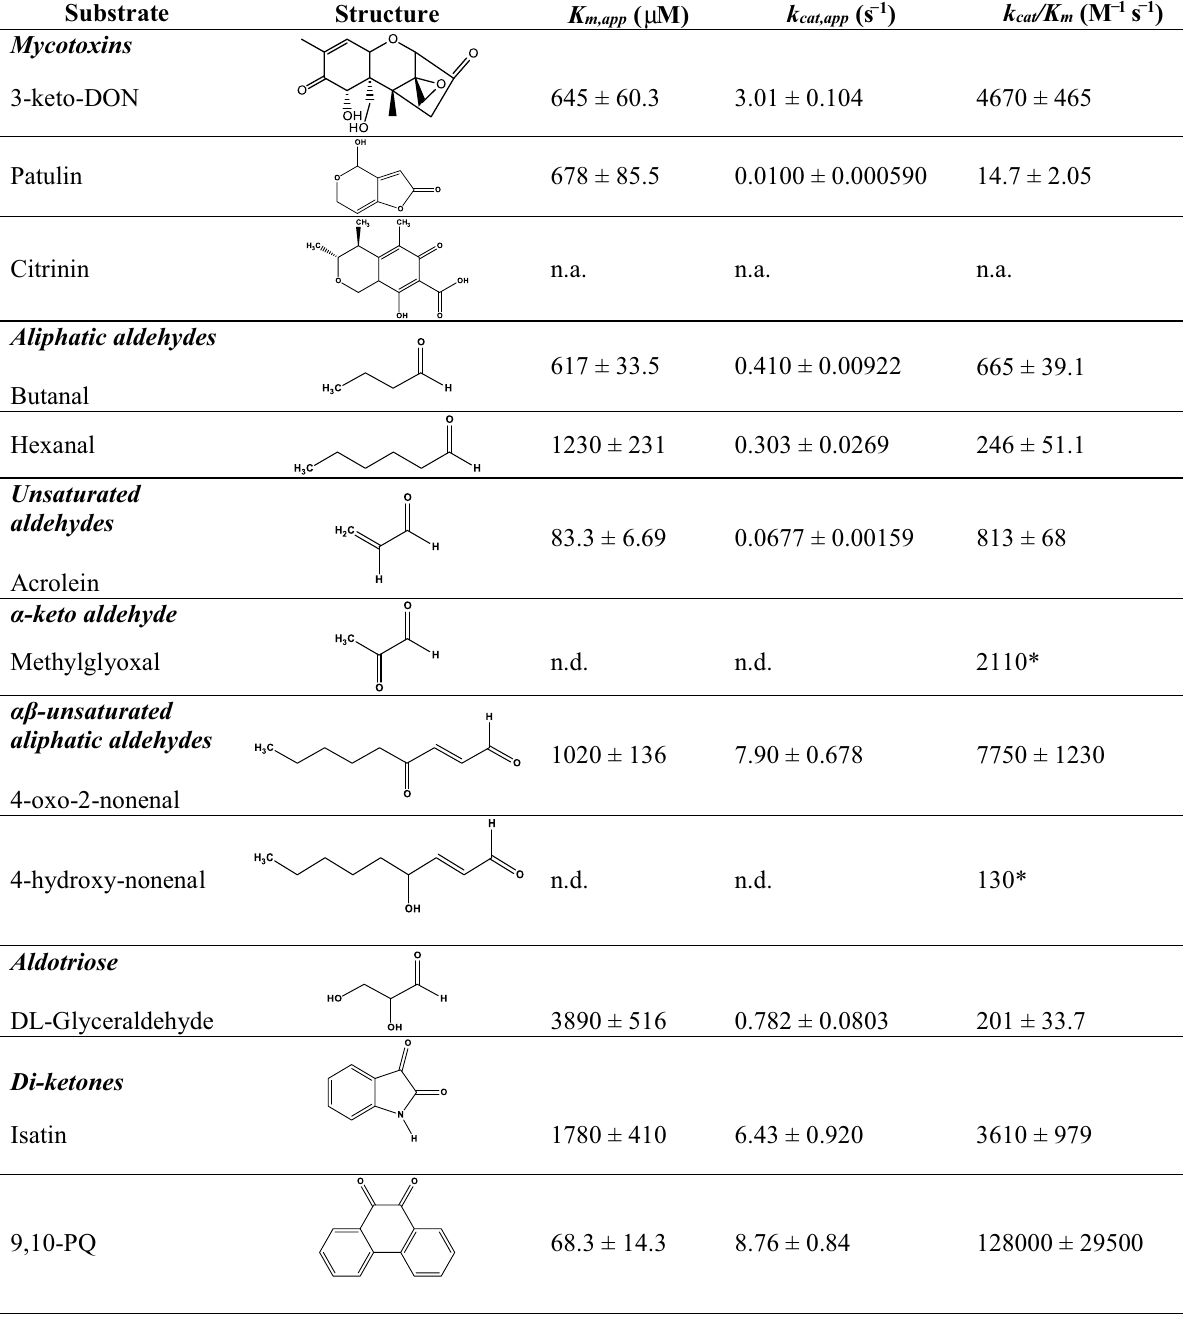
Table 1. Substrate specificity profile of DepB Rleg . Apparent kinetic parameters for reduction of model aldehydes and ketones by recombinant DepB Rleg in the presence of 1 mM NADPH. (n.d. = not determined, n.a. = no activity, *estimated from the gradient of the v vs. [S]